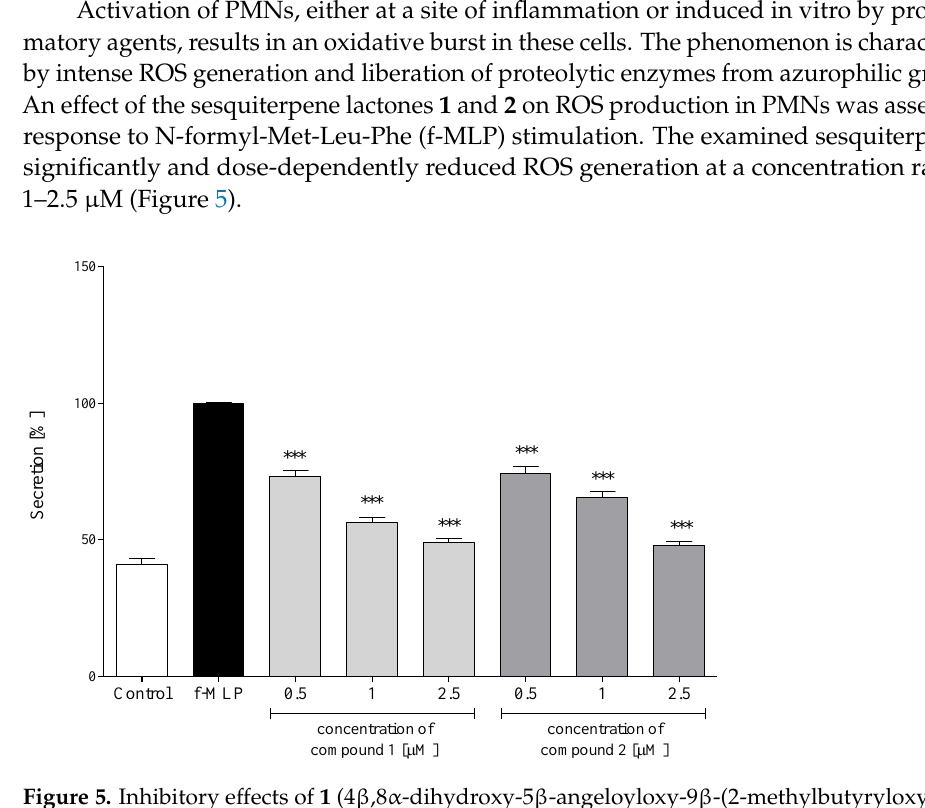
Figure 5. Inhibitory effects of 1 (4β,8α-dihydroxy-5β-angeloyloxy-9β-(2-methylbutyryloxy)-3-oxo- germacran-6α,12-olide) and 2 (cardivarolide G), at concentrations 0.5, 1.0 and 2.5 μM, on the ROS release from f-MLP-stimulated human neutrophils. Statistical significance: *** p < 0.001, with ref- erence to a stimulated control.